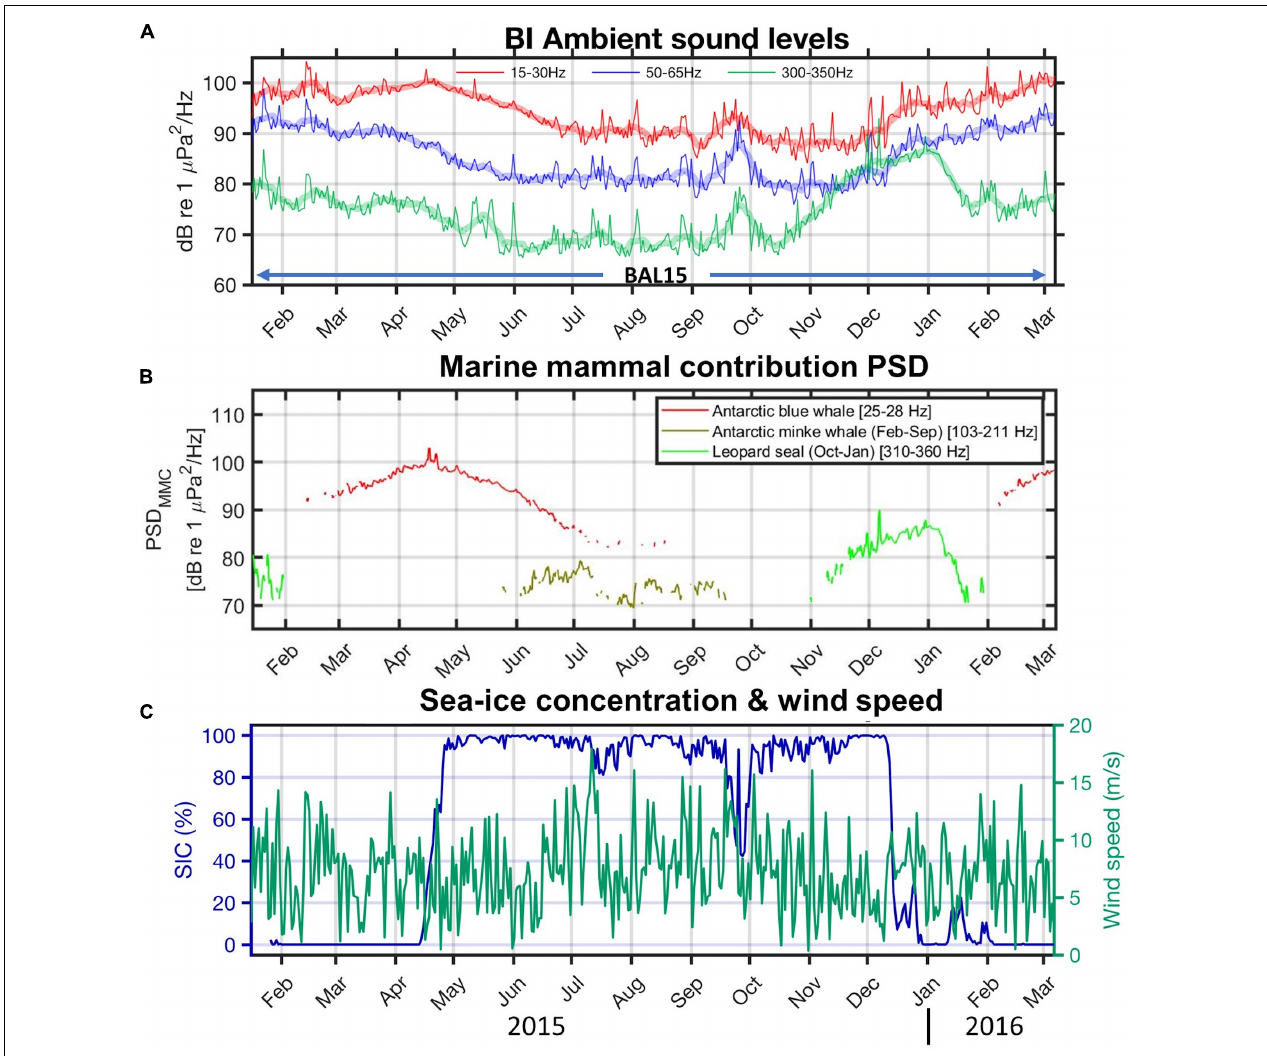
FIGURE 4 | (A) Time series of mean sound levels in particular frequency bands in the BI records: 15–30 Hz for whale calls (red line), 50–65 Hz for cryogenic events (blue), and 300–350 Hz for leopard seal vocalization (green). Ten-day moving averages for each curve are plotted by shaded lines with the same color. (B) Time series (24-h moving averages) of the marine mammal contributions (MMC) in the power spectral density (PSD MMC ): Antarctic blue whale contribution (red line), Antarctic minke whale contribution from February to September 2015 (olive green), and leopard seal contribution from October to January (green). (C) Daily averaged sea-ice concentration within 50 km radius of the BAL15 station (navy line) and time series of the wind speed from ERA5 (Hersbach et al., 2020).